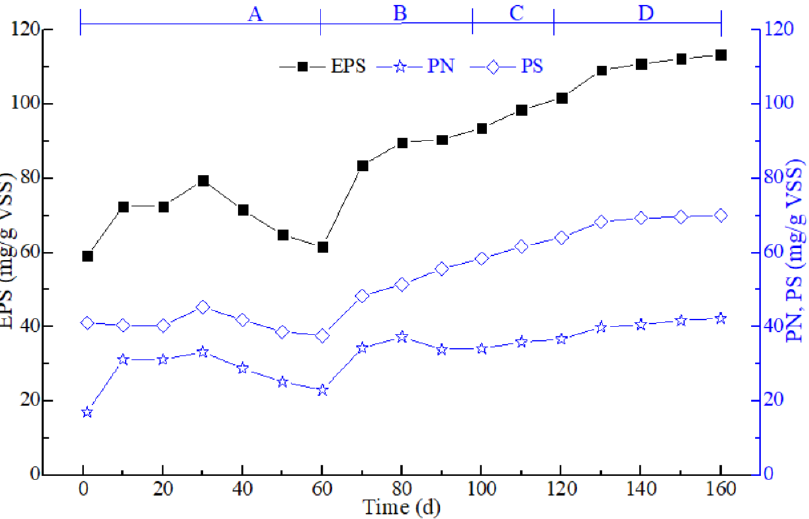
Figure 3. Variation of EPS throughout the whole experiment. Stages A – D are the same as in Figure 1.